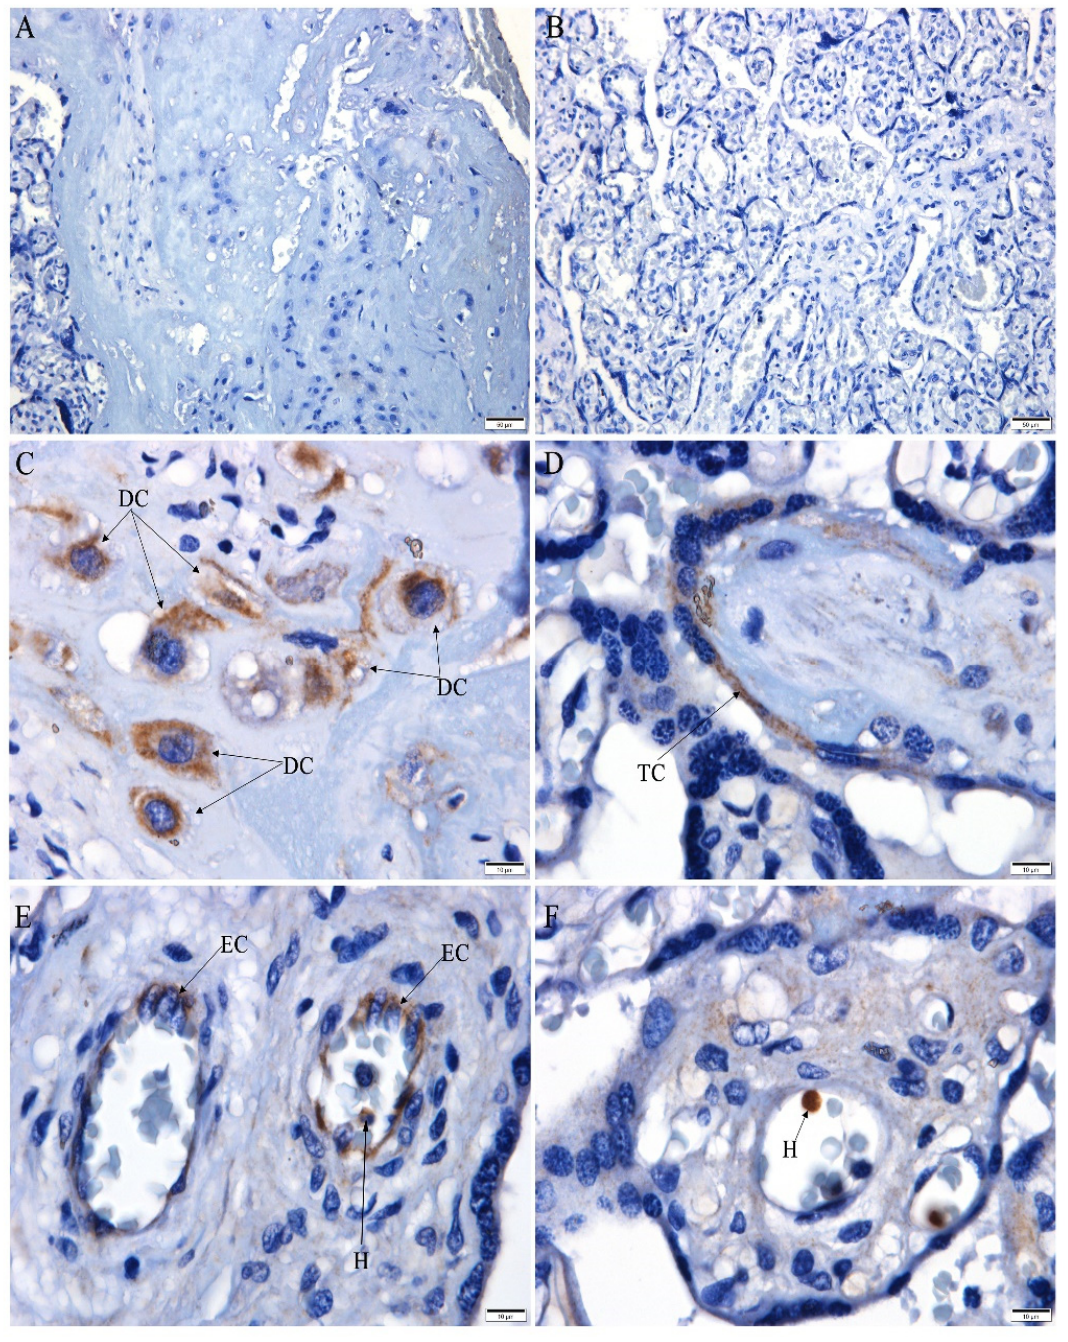
Figure 2. CHIKV antigen detection in the placenta. ( A – B ) Negative CHIKV antigen detection in the control placenta; ( C – F ) infected placenta with CHIKV antigen detection in: ( C ) decidual cells (DC), ( D ) trophoblast cells (TC), ( E ) endothelial cells (EC) and cell inside fetal capillary (H), and ( F ) cell inside fetal capillary (H). Scale bar—( A , B ): 50 µm; ( C – F ): 10 µm).